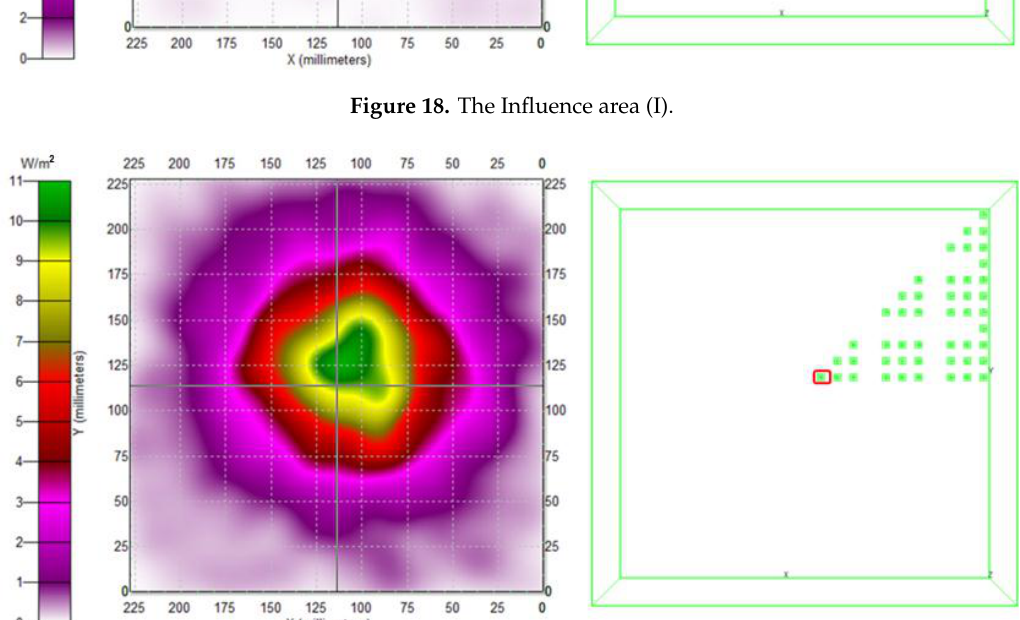
Figure 19. The Influence area (II).